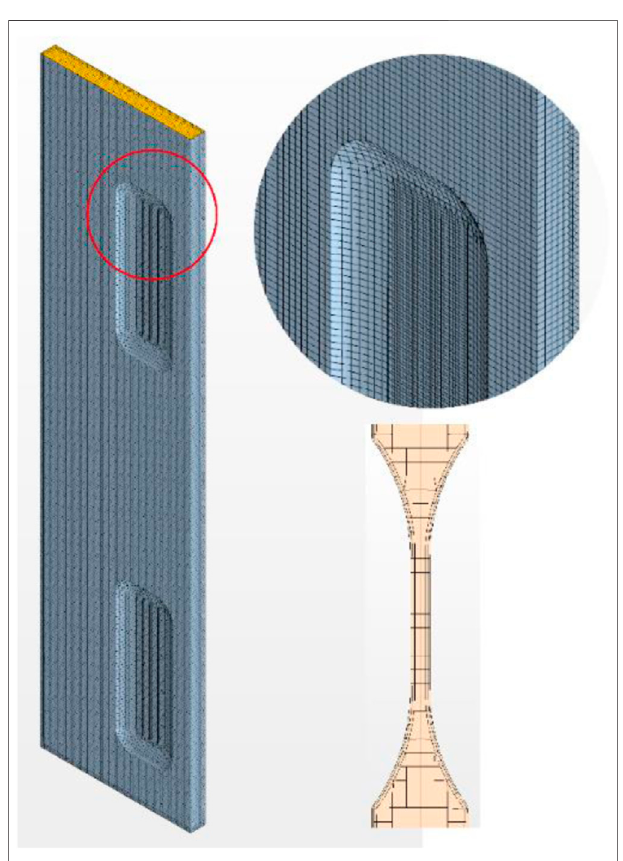
FIGURE 4 | The single-channel pillow bubbling deformation mesh.